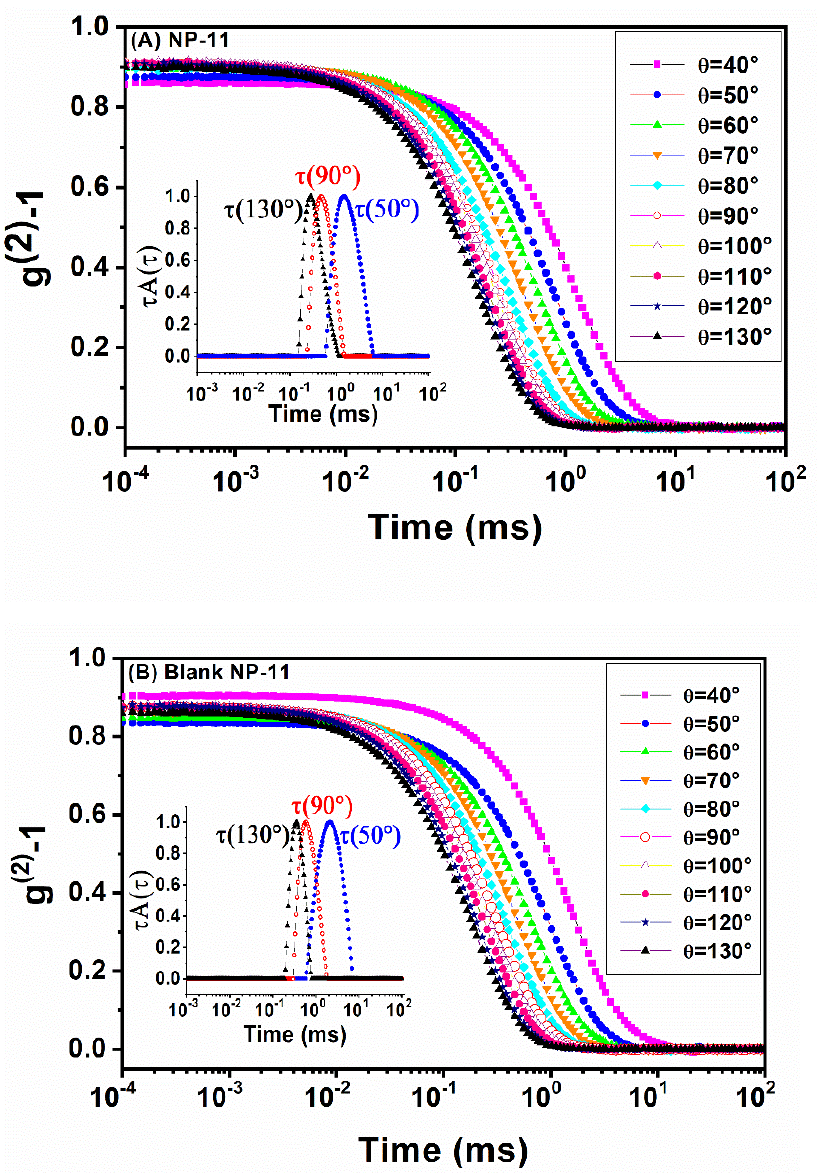
Figure 2. Intensity autocorrelation function (g (2) −1 ) measured at multiangle ( θ ) for ( a ) NP-11 and ( b ) blank NP-11. Inserts present the relaxation-time distribution of each sample at scattering angles of 50°, 90°, and 130°.